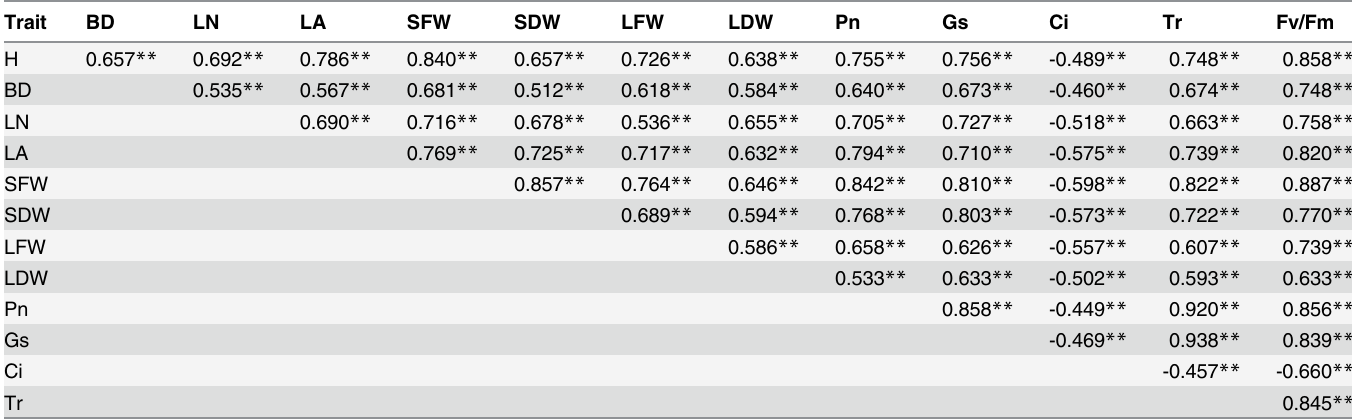
Table 7. Pair-wise correlation coefficients of different